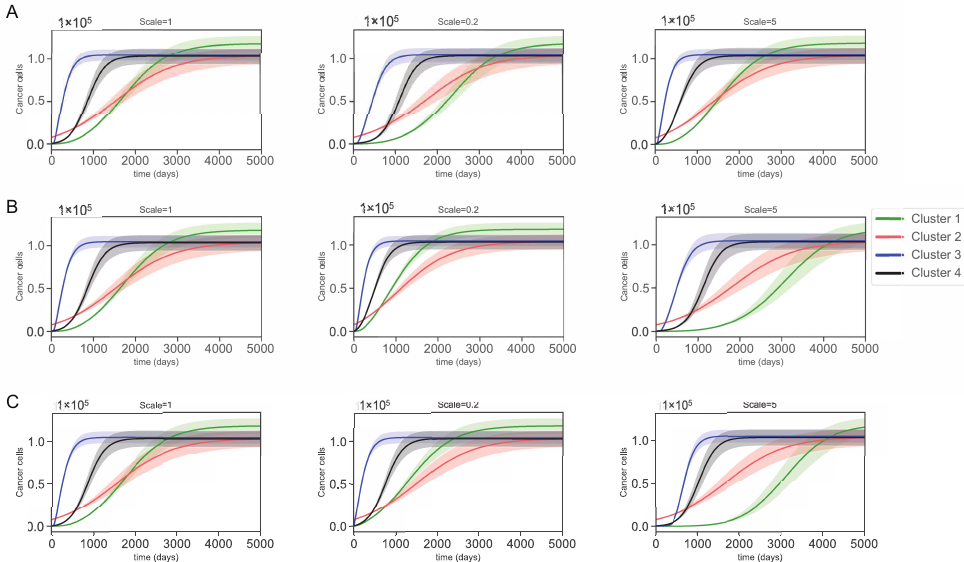
Figure 7. Cancer cell population after using scales 1, 0.2, and 5 in ( A ) assumption (20), ( B ) assump- tion (21), and ( C ) assumption (22) with the transparent region corresponding to 5% perturbation of all of the most sensitive parameters.